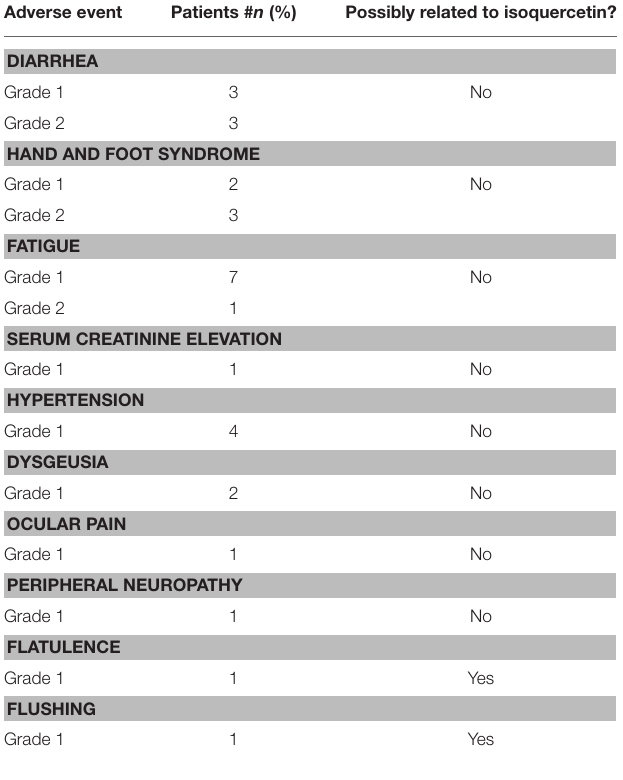
TABLE 3 | Adverse events reported during study treatment.